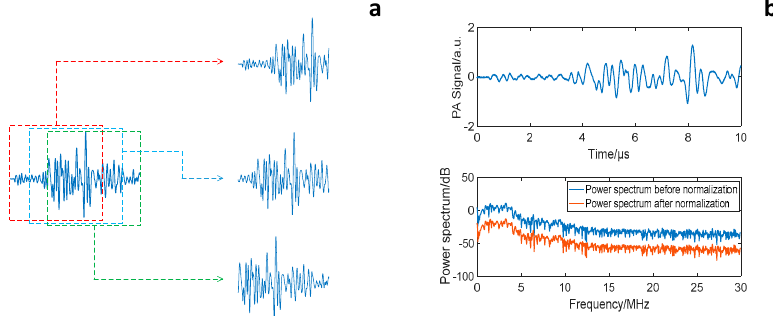
Figure 3. Data augmentation. ( a ) Raw signal was divided into three parts based on time. ( b ) Signal from ( a ) with noise and its power spectrum in log scale before and after normalization.